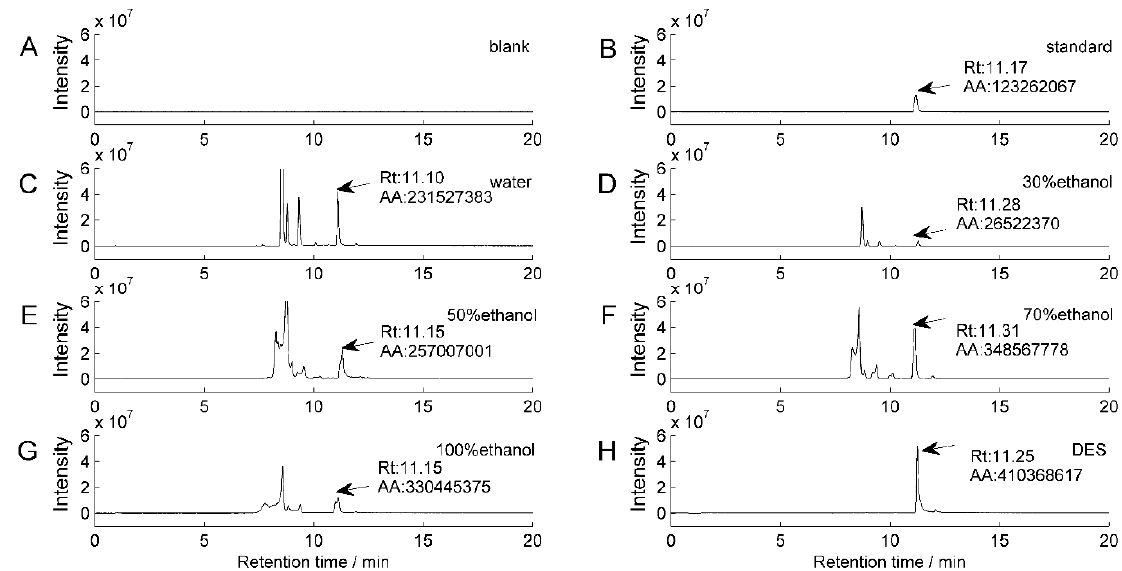
Figure 3. Chromatograms of isofraxidin-extracted ions [M + H] + ( m/z : 223.05977) extracted using various solvents. ( A ) Chromatogram of the aqueous solution as the blank solvent; ( B ) chromatogram of isofraxidin reference standard samples; ( C ) chromatogram of isofraxidin extracted from water solution; ( D ) isofraxidin chromatogram extracted with 30% ethanol; ( E ) isofraxidin chromatogram extracted with 50% ethanol; ( F ) isofraxidin chromatogram extracted with 70% ethanol; ( G ) isofraxidin chromatogram extracted with 100% ethanol; (H) isofraxidin chromatogram extracted with DES.